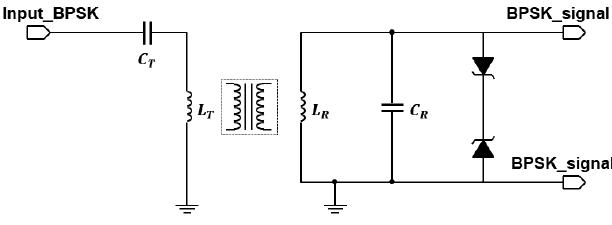
Figure 6. Inductive link